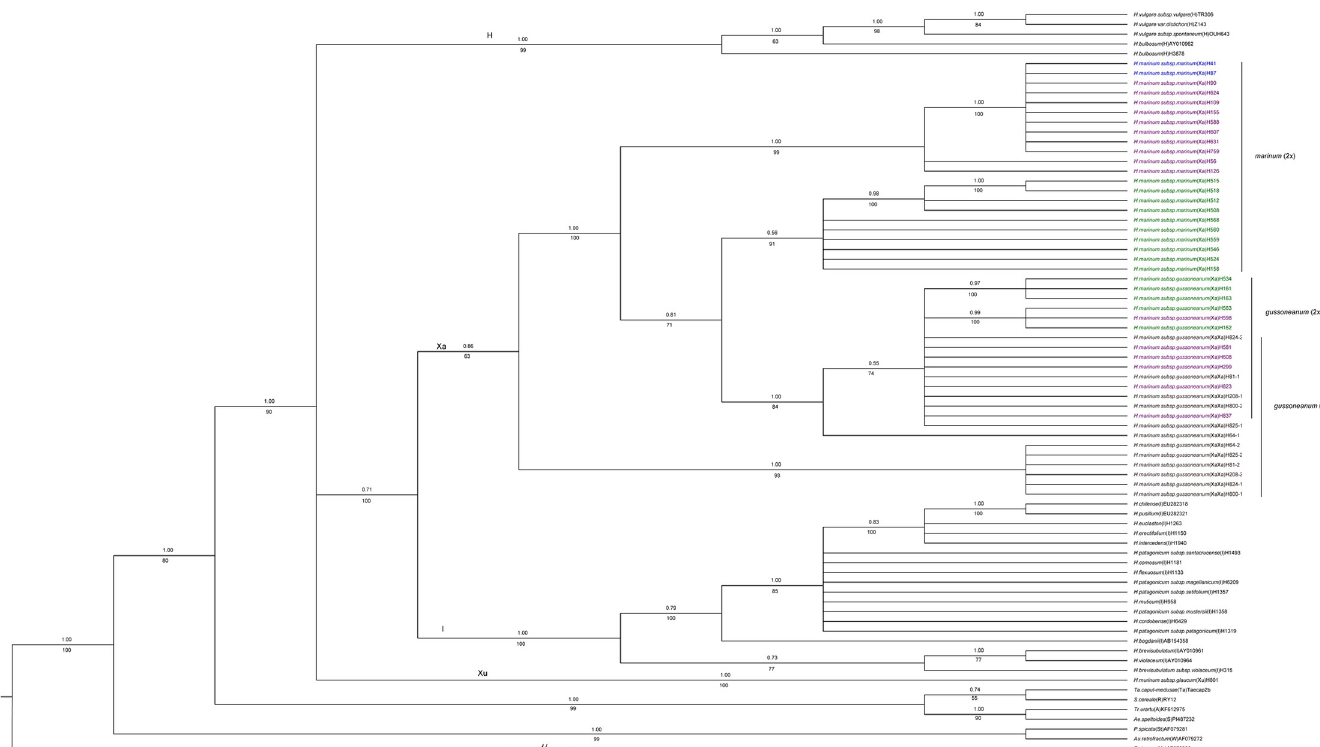
Fig 2. Strict consensus trees derived from WAXY1 sequence data was conducted using the TrN+G+I model by Bayesian analysis. The main topologies generated by Maximum parsimony analysis are similar. Numbers above and below branches are Bayesian posterior probability (PP) values and bootstrap values, respectively. Psathyrostachys juncea was used as the outgroup. Consistency index (CI) = 0.624, retention index (RI) = 0.912. Geographic distribution of species: western Mediterranean (green), central Mediterranean (purple), eastern Mediterranean (blue).